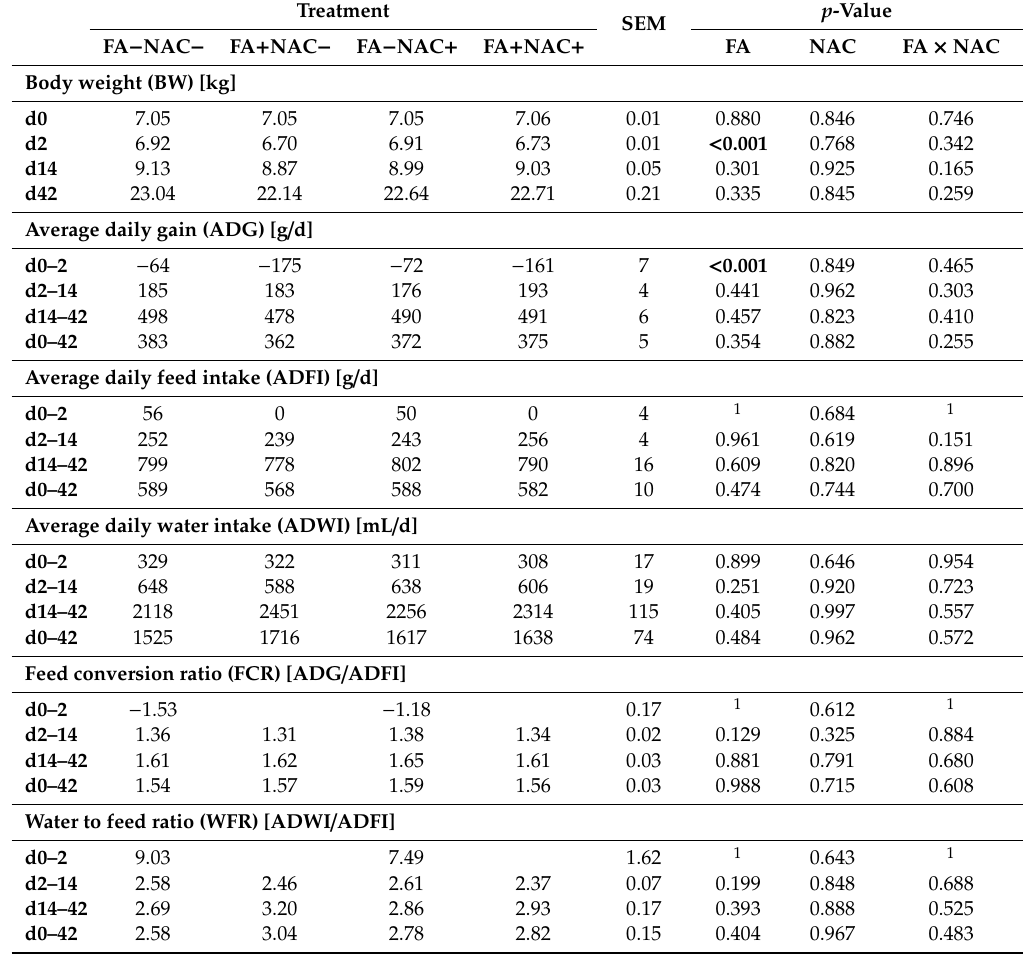
Table 2. Post-weaning animal performance of piglets either or not fasted from d0–2 (respectively FA + and FA − ) and either or not supplemented with N -acetyl cysteine (NAC) via the drinking water at 200 mg / L (respectively, NAC + and NAC − ) ( n =